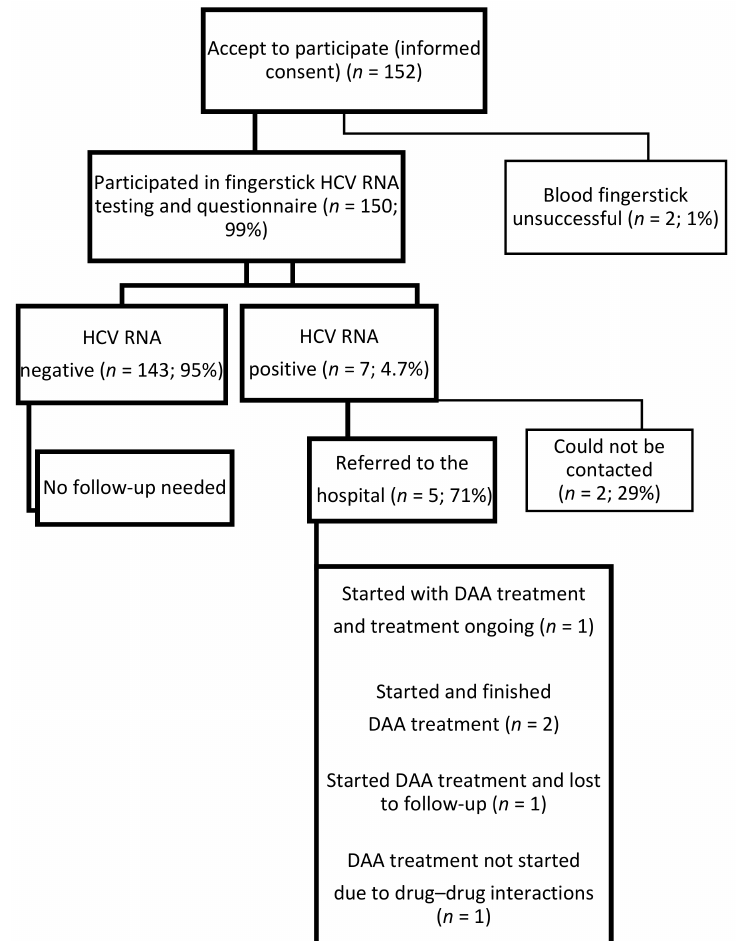
Figure 1. Flowchart for recruitment, study procedures, and linkage to care in eight homelessness services in Amsterdam, the Netherlands, January–March